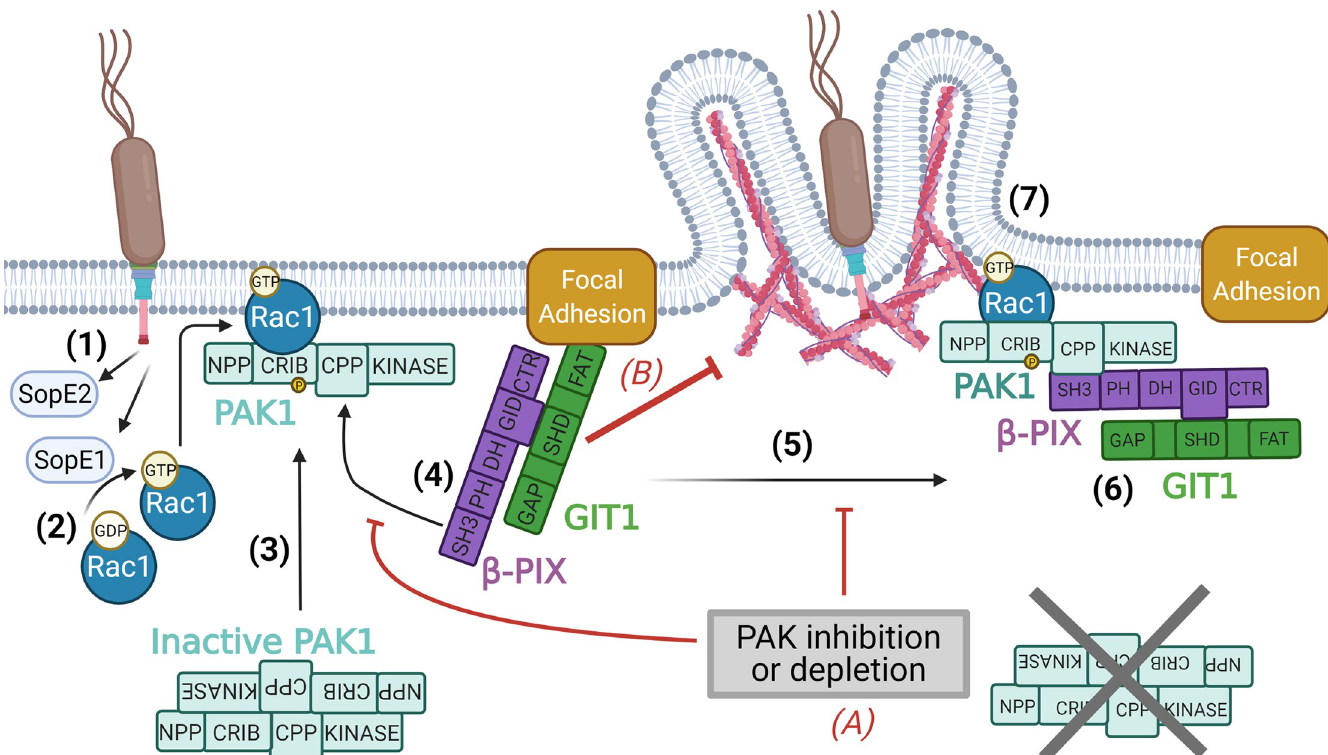
Fig 7. Model: PAK drives Salmonella uptake. (1) When in contact with the host cell Salmonella injects effector proteins into the cytoplasm using its T3SS. (2) Two of these effectors (SopE1 and SopE2) activate the small GTPases Rac1 and Cdc42. (3) Rac1 (or Cdc42) binds to the PAK CRIB domain, recruiting PAK to the plasma membrane. (4) PAK can recruit β -PIX through an interaction between its CPP and β -PIX’s SH3 domain. (5) The β -PIX-GIT complex is pulled out of the FA. (6) Once removed from the FA β -PIX no longer exerts a negative effect on Salmonella uptake. (7) The local cellular environment is now conducive to the actin reorganisation that drives bacterial internalisation. (A) In the absence of PAK (through depletion or inhibition) (B) β -PIX remains in the FA where it impedes Salmonella invasion either via modulating FA dynamics, and/or by sequestering Rac1 away from the bacterial entry site. This inhibition is dependent on β -PIX GEF activity. Created with BioRender.